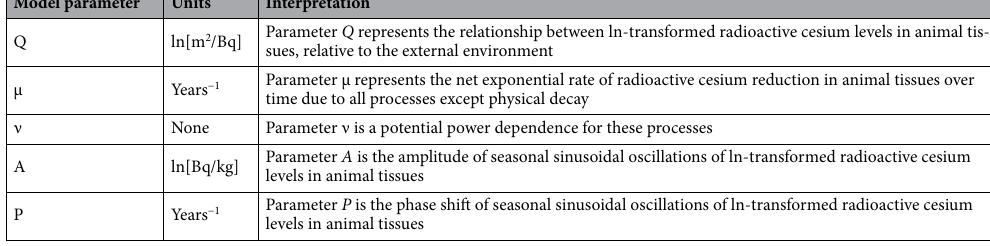
Table 1. The meanings of all parameters used in our mathematical model (Eq. 1A, 1B) for radioactive cesium levels in wild boar ( Sus scrofa ) and Asian black bear ( Ursus thibetanus